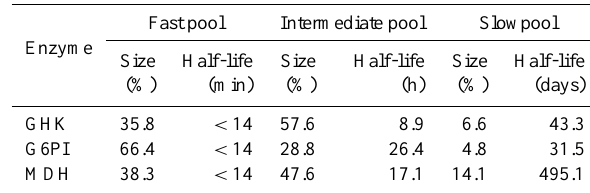
Table 2. Size and half-time of fast, intermediate and slow pools of respiratory enzymes in the non-irradiated-soil from